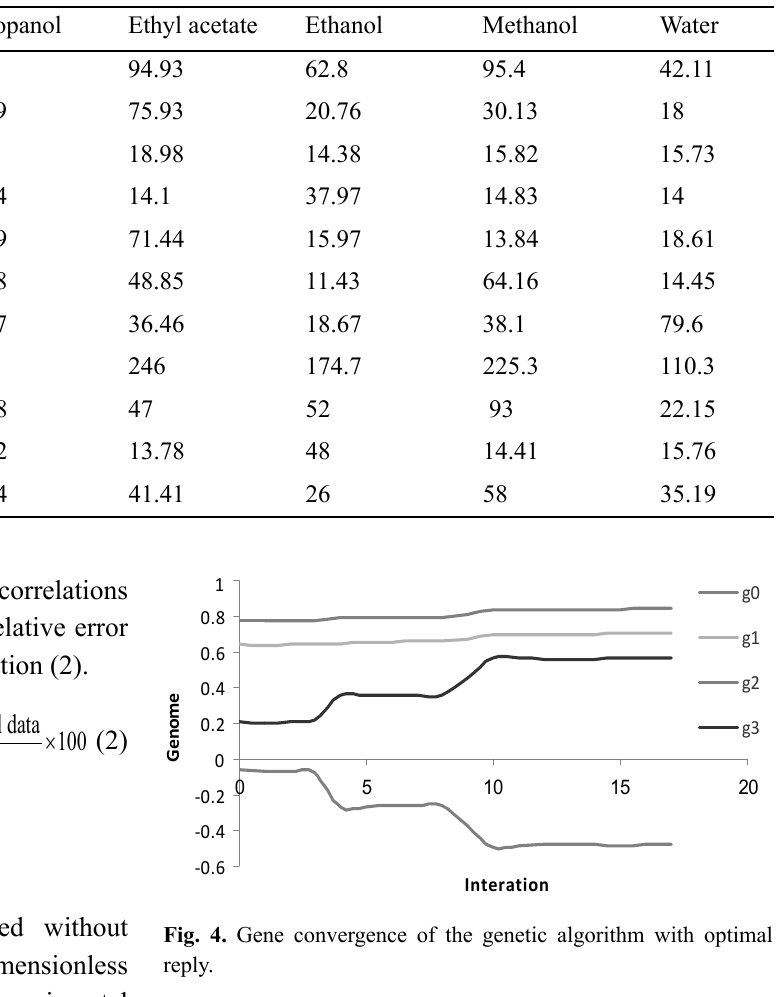
Table 4. Percentage of average absolute error for pure